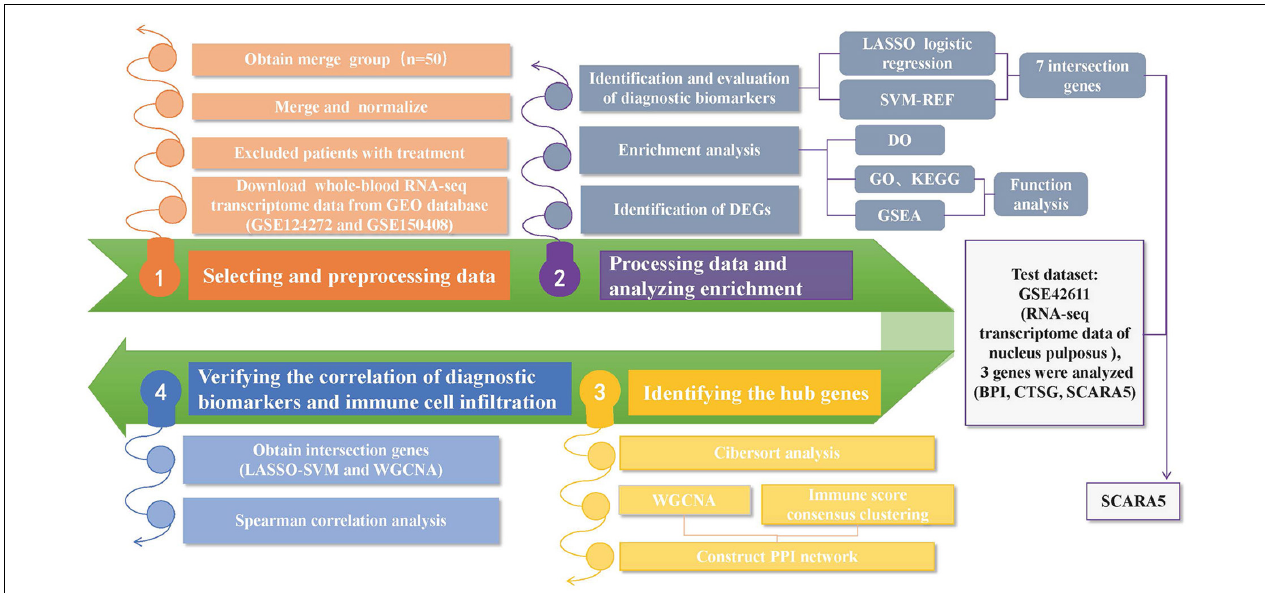
FIGURE 1 | A flow-process diagram showing the analysis steps in this study (GEO: Gene Expression Omnibus; DEGs: Differentially Expressed Genes; ROC: Receiver operating characteristic; LASSO: Least Absolute Shrinkage and Selection Operator; SVM-RFE: the support vector machine recursive feature elimination; GO: Gene Ontology; KEGG: Kyoto Encyclopedia of Genes and Genomes; DO: Disease Ontology; GSEA: Gene Set Enrichment Analysis; WGCNA: Weighted Gene Coexpression Network Analysis; PPI: Protein-protein